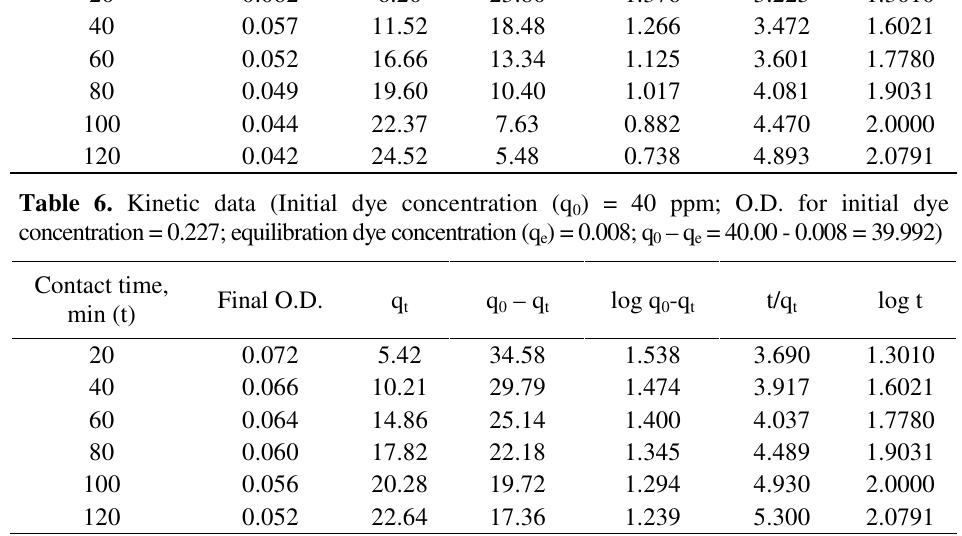
Table 5. Kinetic data (Initial dye concentration (q concentration = 0.214; equilibration dye concentration (q Contact time,